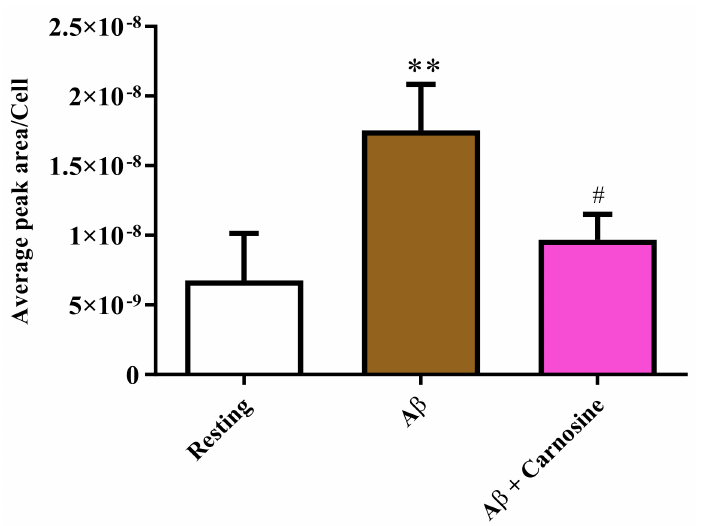
Figure 4. Detection of intracellular concentrations of ROS (expressed as average peak area per cell) in resting RAW 264.7 cells and in RAW 264.7 cells stimulated with A β 1-42 oligomers (2 µ M) in the absence or presence of carnosine (20 mM; 1 h pre-treatment). Values are means ± SD of three independent experiments. Standard deviations are represented by vertical bars. ** significantly different from resting cells, p < 0.01; # significantly different from A β 1-42 oligomer-treated cells, p <